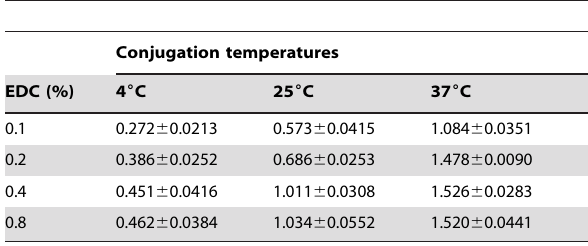
Table 4. Absorbance of anti-DBP antibody bound to hapten- coated polystyrene wells.